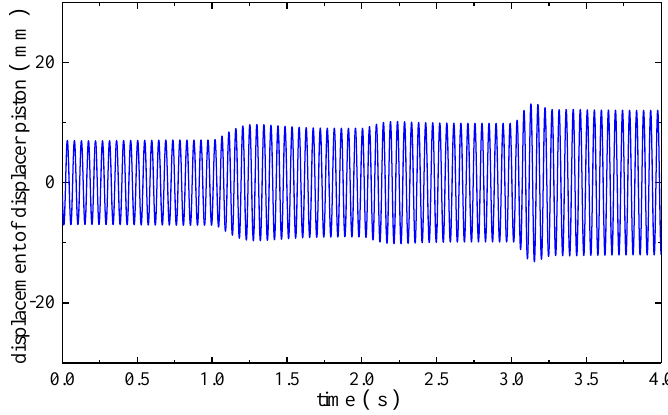
Figure 7. Piston displacement for different resistances.